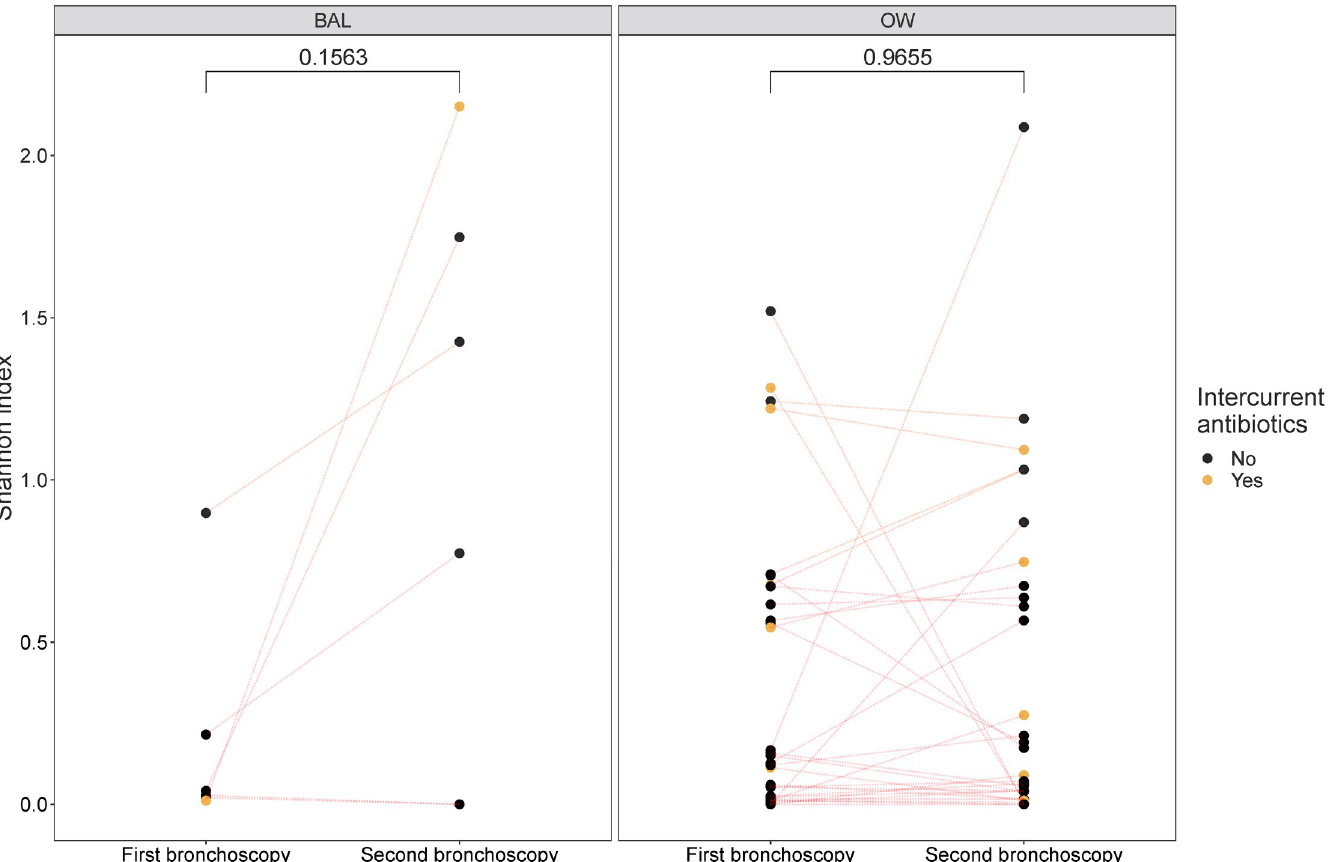
Fig 3. Analysis of alpha diversity differences between first and second bronchoscopy. BAL: bronchoalveolar lavage, OW: oral wash. A line was drawn between samples from the same participant, divided in BAL (12 samples) and OW (62 samples). Differences in Shannon were statistically tested with Wilcoxon signed-rank test with a significance level of